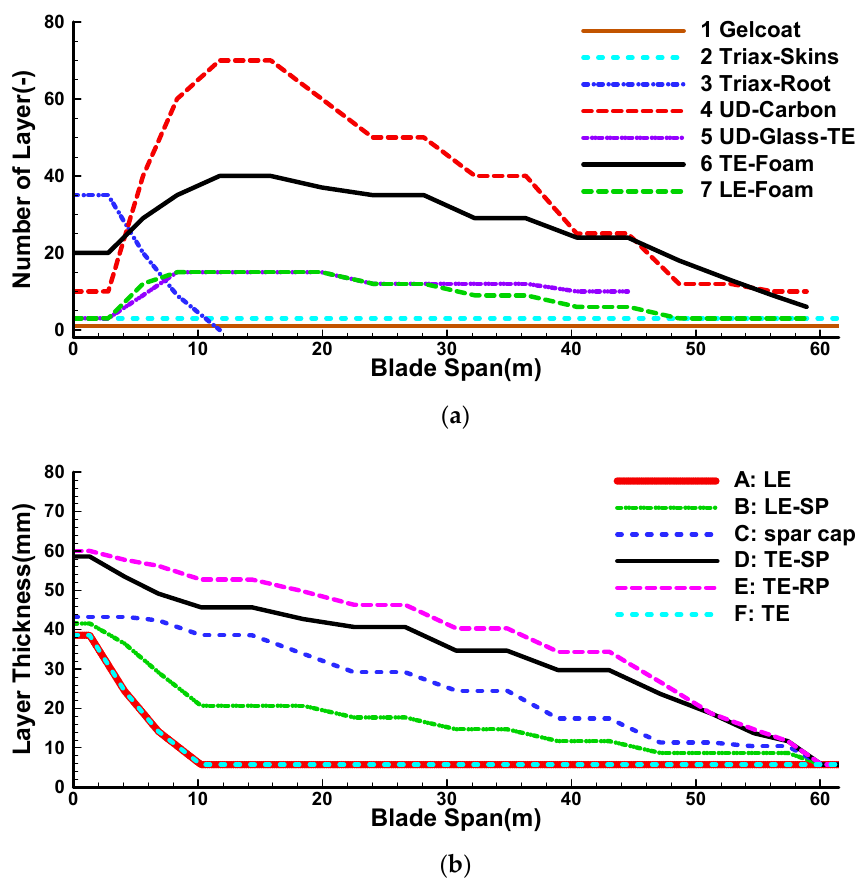
Figure 30. Layup design of the NPU 5 MW blade: ( a ) number of layers; ( b ) thickness of layer.